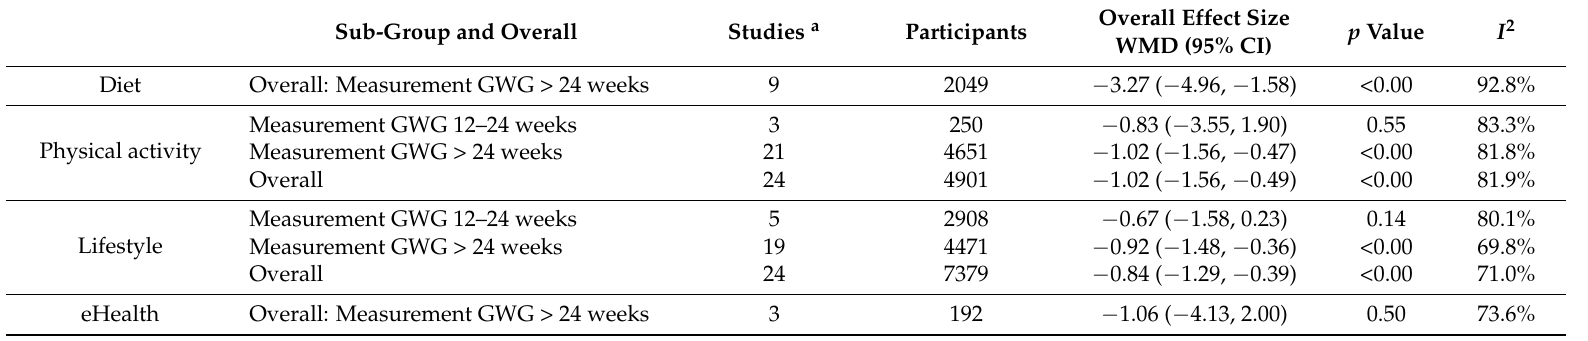
Table 1. Random-effects meta-analyses for diet, physical activity, lifestyle, and eHealth interventions (WMD and 95% CI). (Figures of meta-analyses are Supplementary Figures S1–S4).